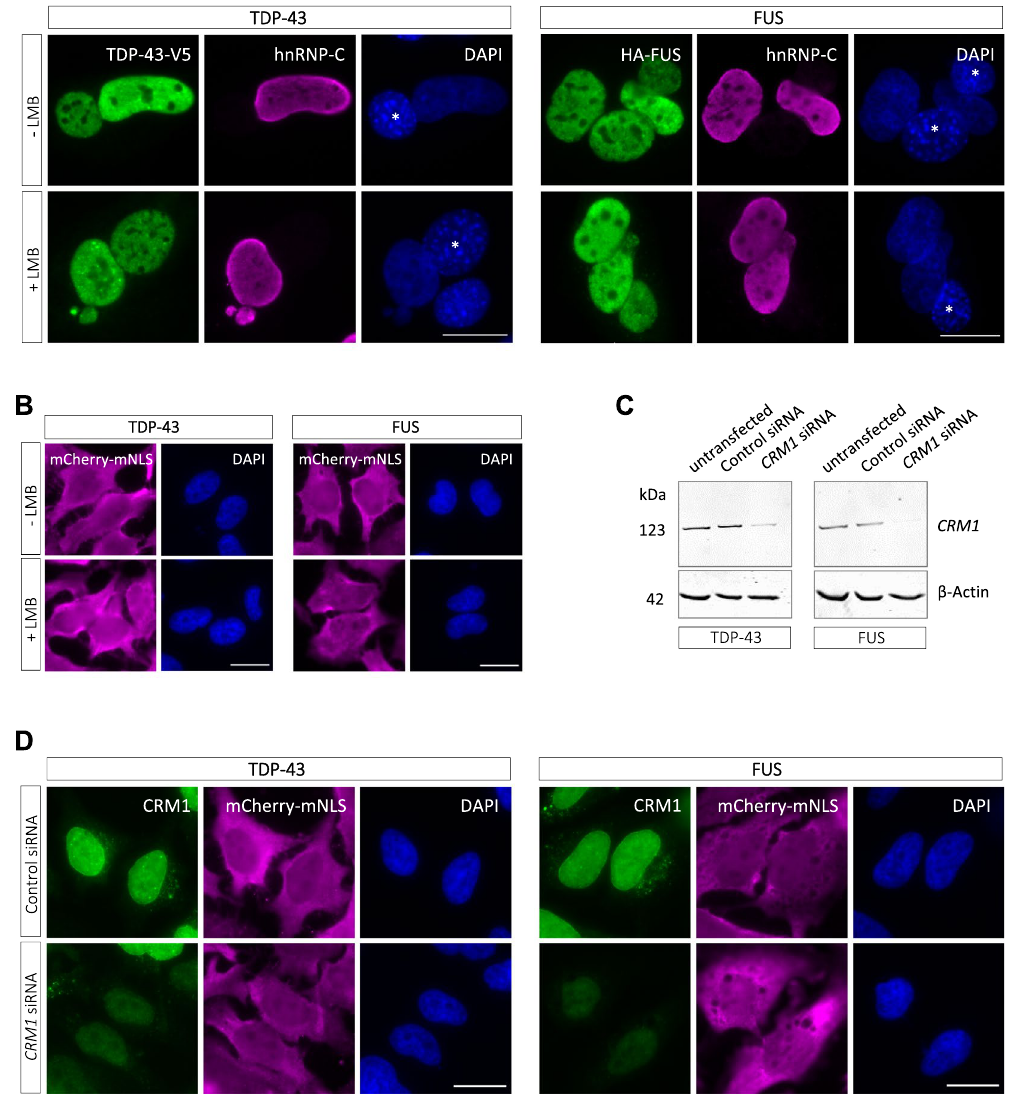
Figure 2. Nuclear export of TDP-43 and FUS is CRM1-independent. ( A ) Heterokaryon assay performed to analyze nuclear export of TDP-43 and FUS with or without CRM1 inhibition. 20 nM Leptomycin B (LMB) was added to heterokaryons directly after fusion and cells were incubated for 2 h (TDP-43) and 3 h (FUS), respectively, in the presence of cycloheximide. Cells were stained with a V5- or HA-specific antibody (green), a human hnRNP-C-specific antibody (magenta) and DAPI as a nucleic acid stain (blue). LMB does not inhibit shuttling of TDP-43 and FUS from human to mouse nuclei (marked with an asterisk in the DAPI channel), demonstrating that export of TDP-43 and FUS is CRM1-independent. Scale bars: 20 μ m. ( B ) Hela cells stably expressing mCherry-tagged TDP-43 and FUS with mutated NLS (mNLS) were treated with LMB (20 nM) for 2.5 hours. LMB treatment does not cause a nuclear accumulation of NLS mutant proteins. Scale bars: 20 μ m. ( C ) and ( D ) HeLa cells stably expressing mCherry-TDP-43-mNLS or mCherry-FUS-mNLS were transfected with control or CRM1 -specific siRNA. 3 days post-transfection, CRM1 levels in total cell lysates were analyzed by Western blotting, β -actin served as a loading control. ( C ) In parallel, cells were stained with a CRM1- specific antibody (green), a mCherry-specific antibody (magenta) and DAPI and were imaged by fluorescence microscopy. ( D ) Cells with reduced CRM1 levels do not show a nuclear accumulation of mCherry-tagged NLS mutant TDP-43 or FUS. Scale bars: 20 μ